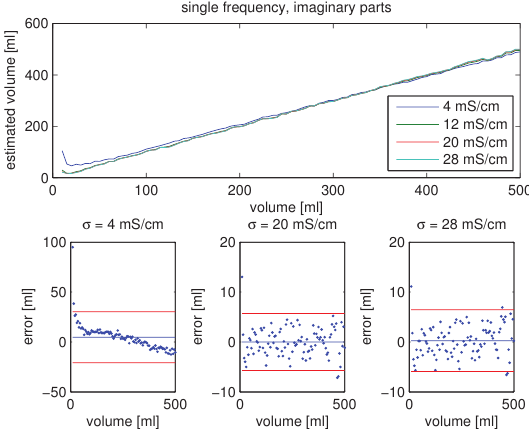
Fig.9: In-silico results for single-frequency variant using imagin- ary parts: For urine volumes higher than 100ml the method works as